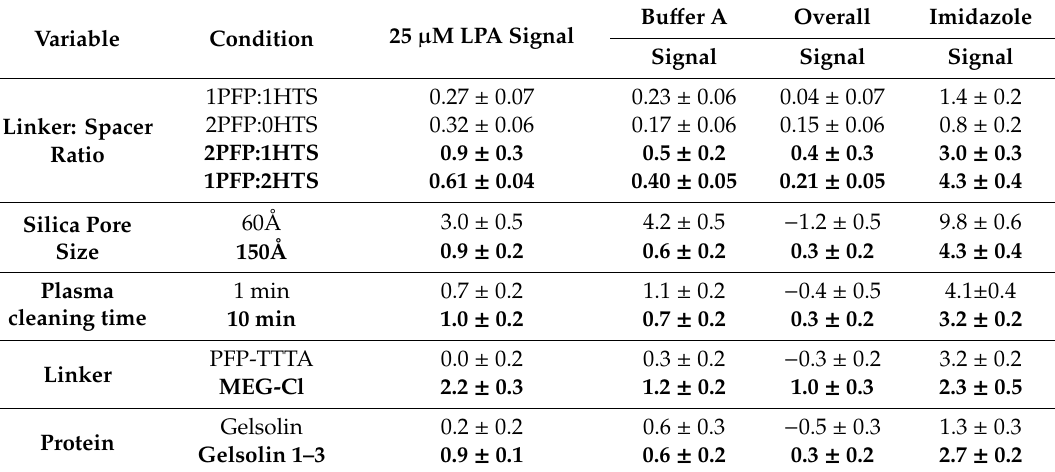
Table 1. Fluorescence data for initial test development with di ff erent variable for surface preparation. Bolded rows were the preferred conditions as given by the overall fluorescence signal for 25 µ M LPA in Bu ff er A.